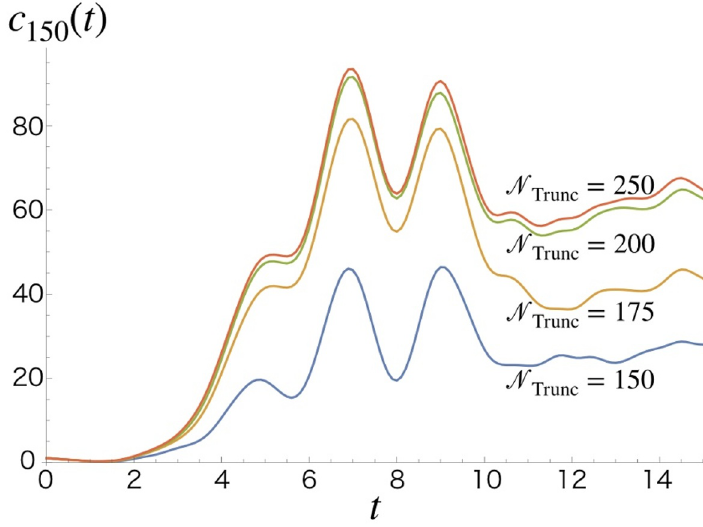
Figure 14 . Microcanonical OTOC c n ( t ) with n = 150 given in (3.7), with the sum over the index m truncated at N trunc